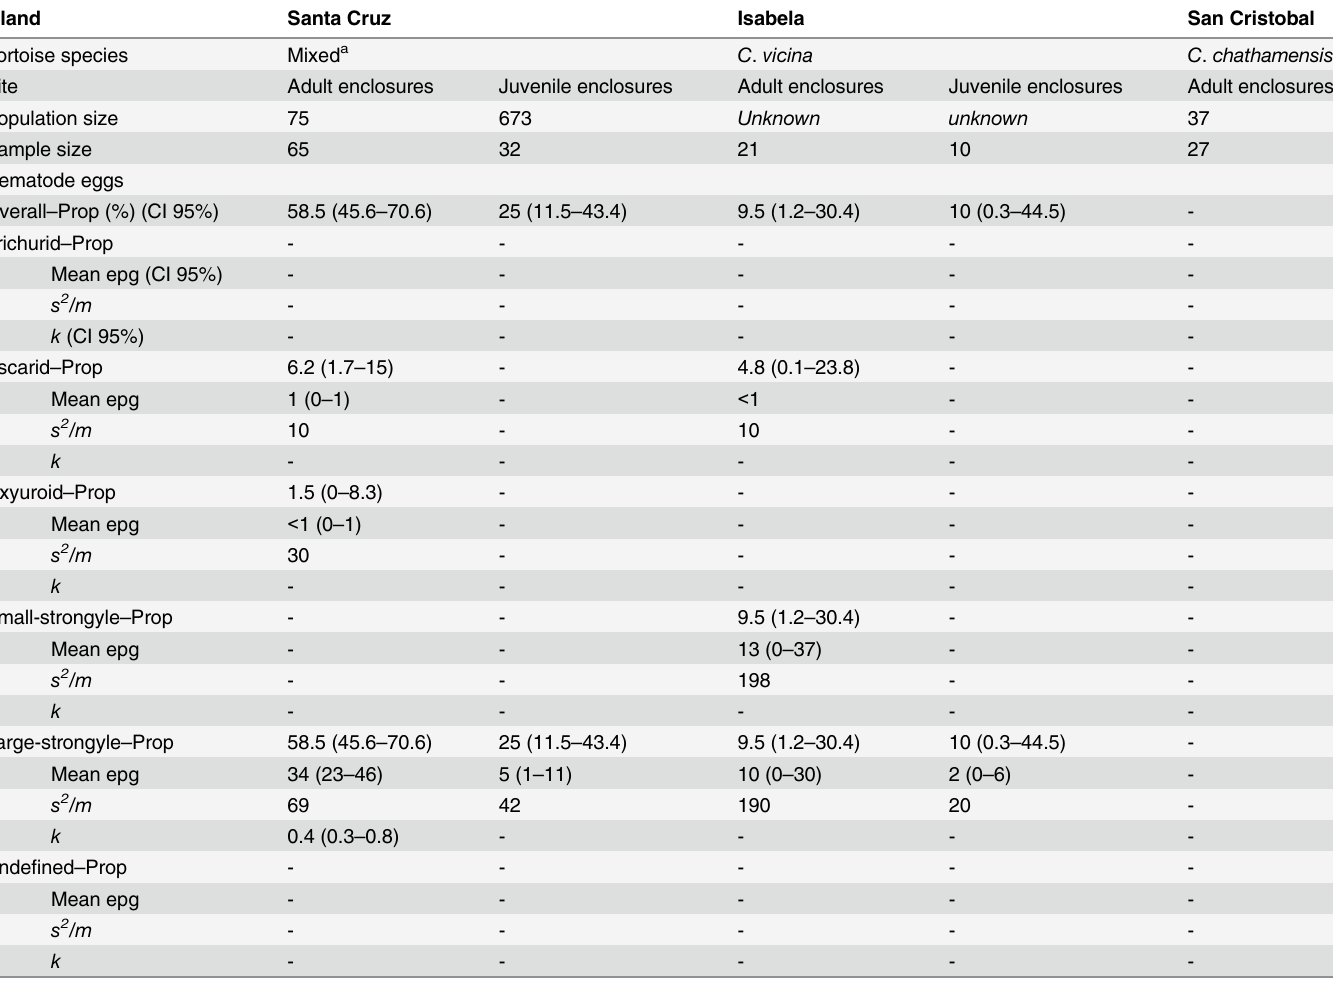
Table 2. Captive Galápagos giant tortoise ( Chelonoidis spp.) faecal samples collected and the results of parasitological examinations.